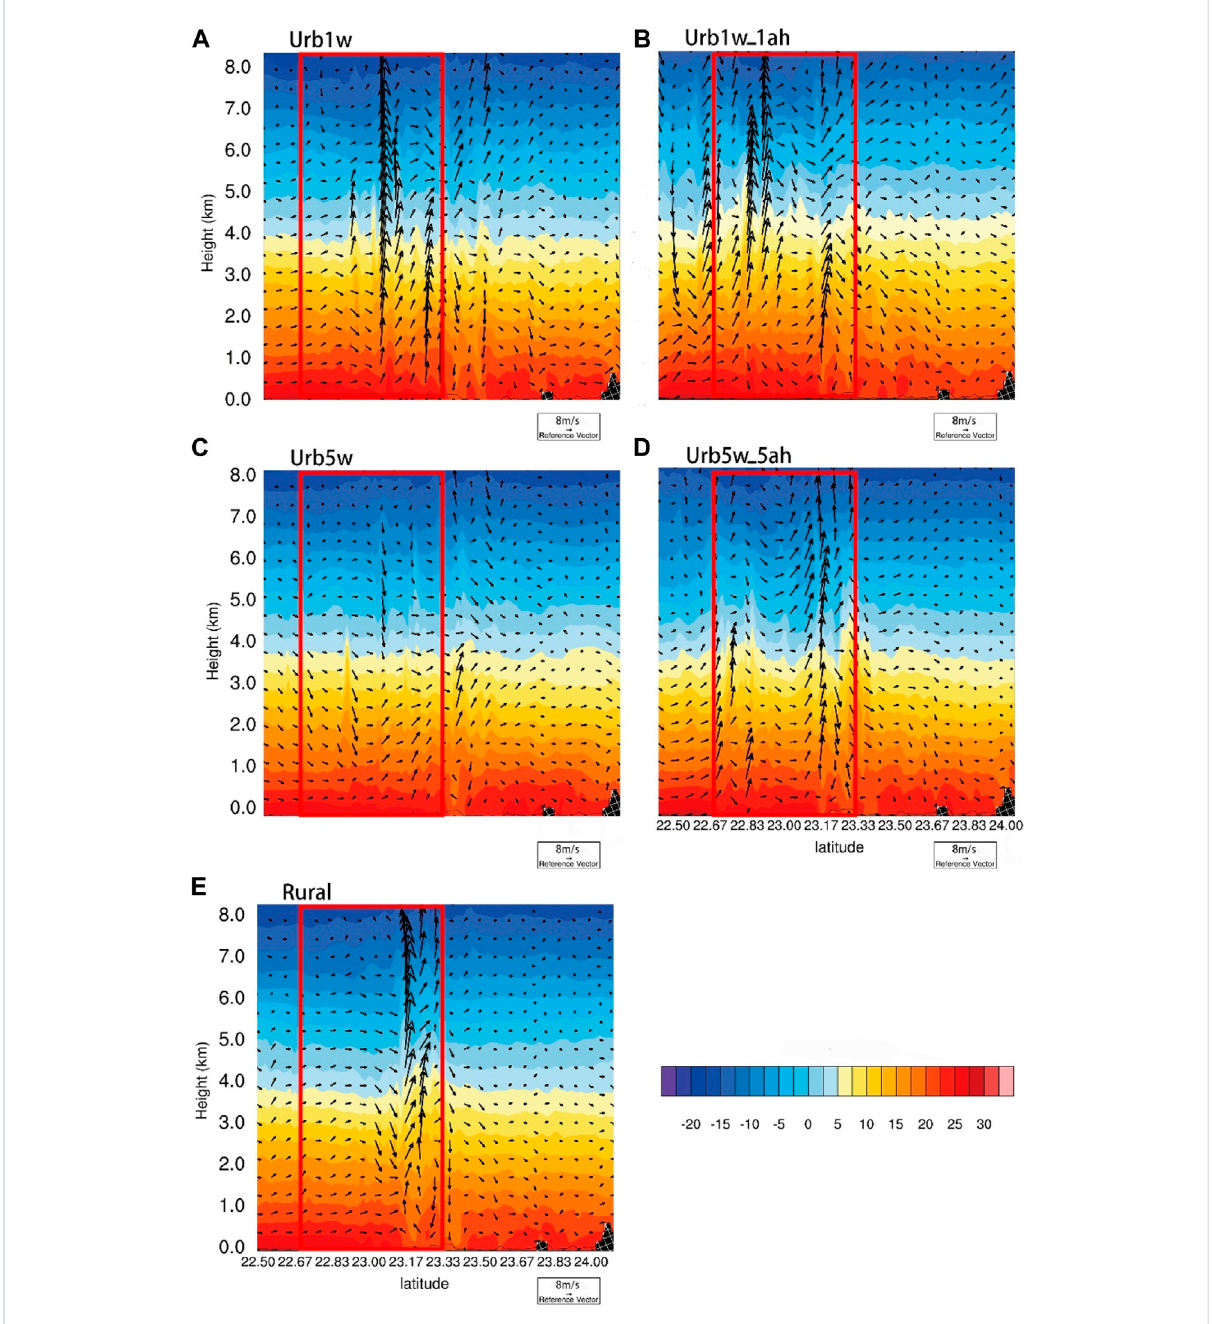
FIGURE 10 Latitude – heightsections(22.50 ° – 24.00 ° N;blacklineinFigure1D)overthePRDUA(113.5 ° E)at1200LST20Aprilofthewind(arrows;unit:m · s − 1 ) and air temperature (color shading; unit: ° C) in the (A) Urb1w, (B) Urb1w_1ah, (C) Urb5w, (D) Urb5w_5ah and (E) Rural experimental group, respectively. The red frame represents the PRDUA. For clarity, the vertical velocity is multiplied by